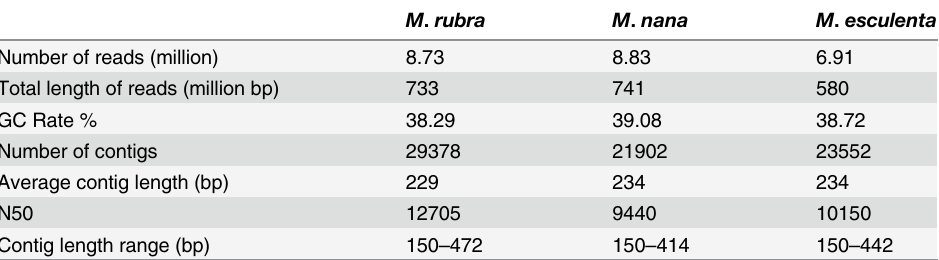
Table 2. Detail information of RAD-tag sequencing.